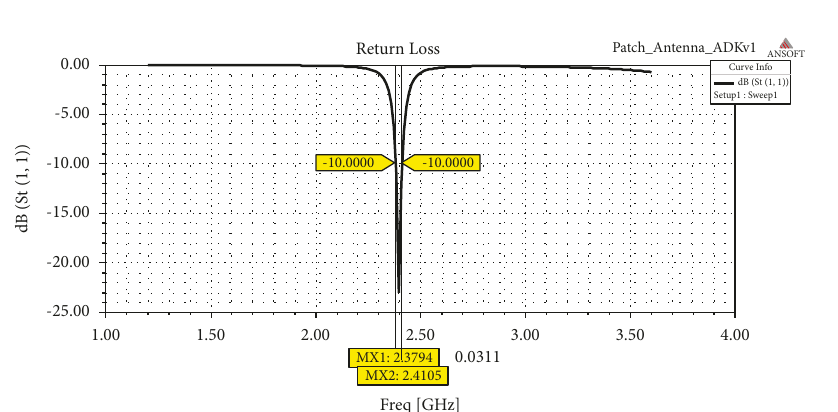
Figure 2: The return loss versus frequency of the reference antenna ( f � 2.4 GHz and S